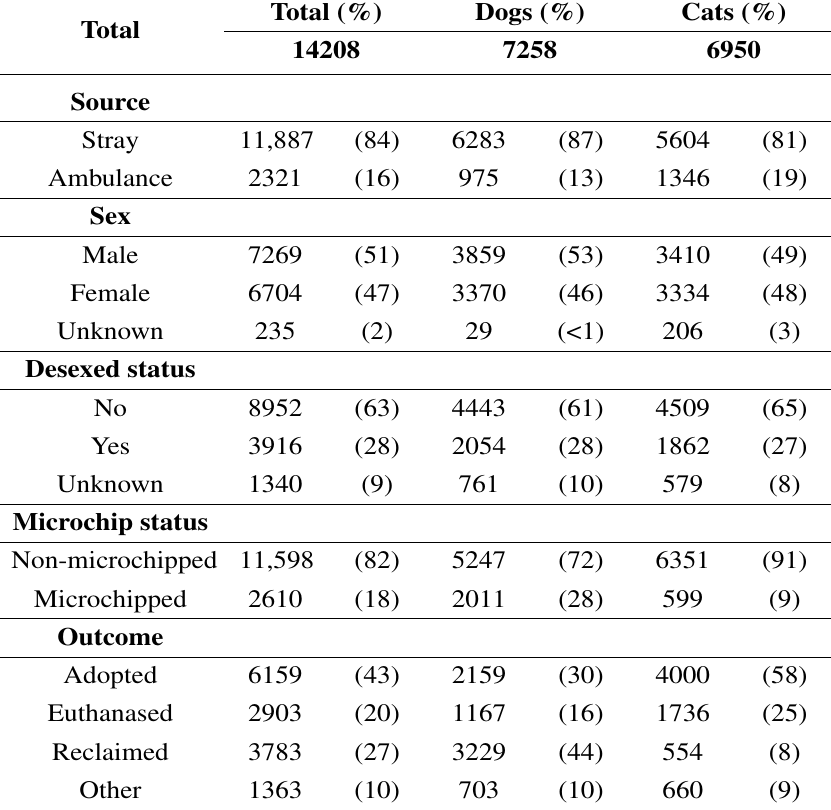
Table 1. Descriptive statistics of stray adult dogs and cats admitted to RSPCA-QLD shelters (January 2012–December 2013). Percentage of source, sex, desexed status, microchip status and outcome is shown in